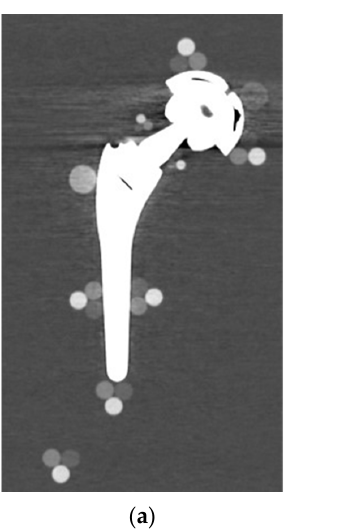
Figure 3. TI unilateral configuration, coronal reconstruction (bone CT visualization window WL:300, WW:1500 ( a ) virtual monochromatic imaging (VMI) reconstructed at 130 keV; and ( b ) virtual monochromatic reconstruction imaging (VMI) reconstructed at 130 keV + metal artifact reduction spectral (MARS) algorithm.